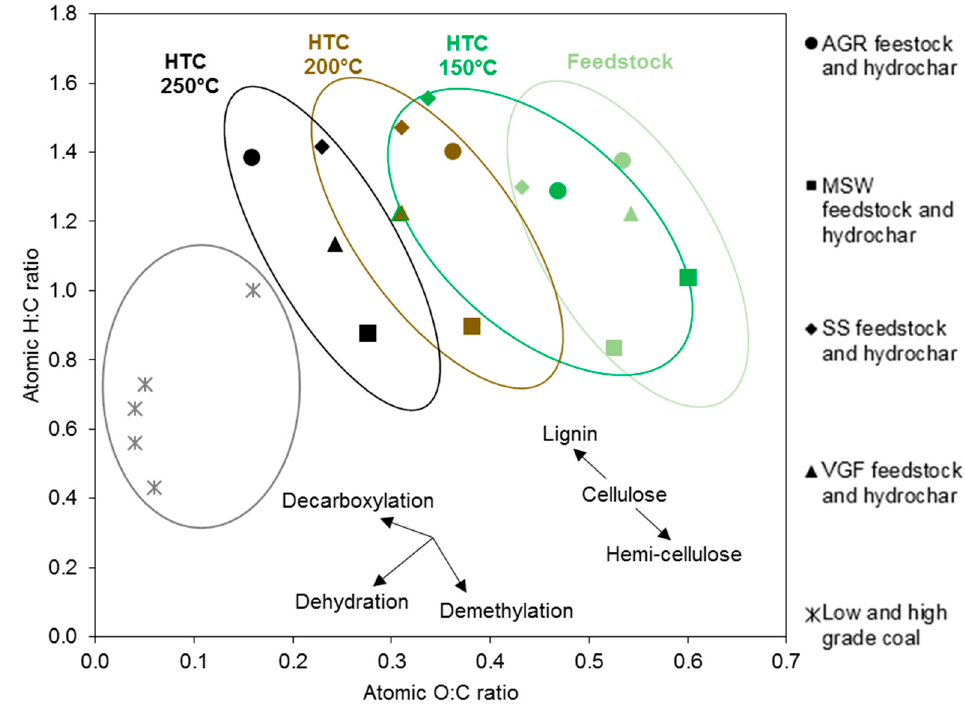
Figure 3. Van Krevelen diagram for feedstock and hydrochar produced at 20% loading. Table 4. Slagging and fouling indices of feedstock and corresponding 20% hydrochar. Slagging and Fouling Indices Material AI BAI R b /